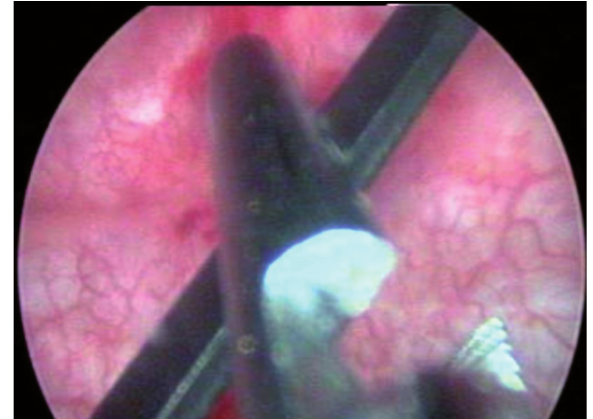
Figure 2 - Cystoscopic view of holding broken blade with Double J removal forceps.